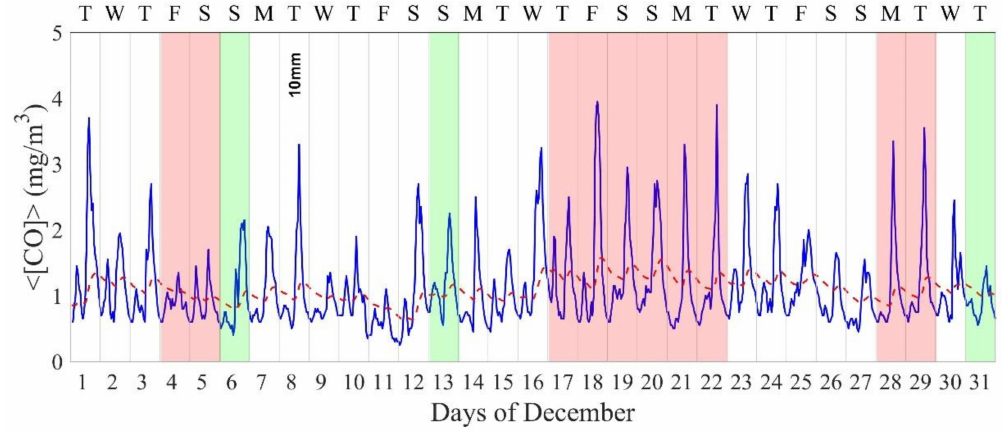
Figure 9. Carbon monoxide concentration variation related to the total block of urban traffic (green band) and alternated plates (red band) of December 2015. The blue line is the hourly pollutant concentration. The red dashed line is the daily mean pollutant concentration. Data of daily precipitation are indicated in mm.